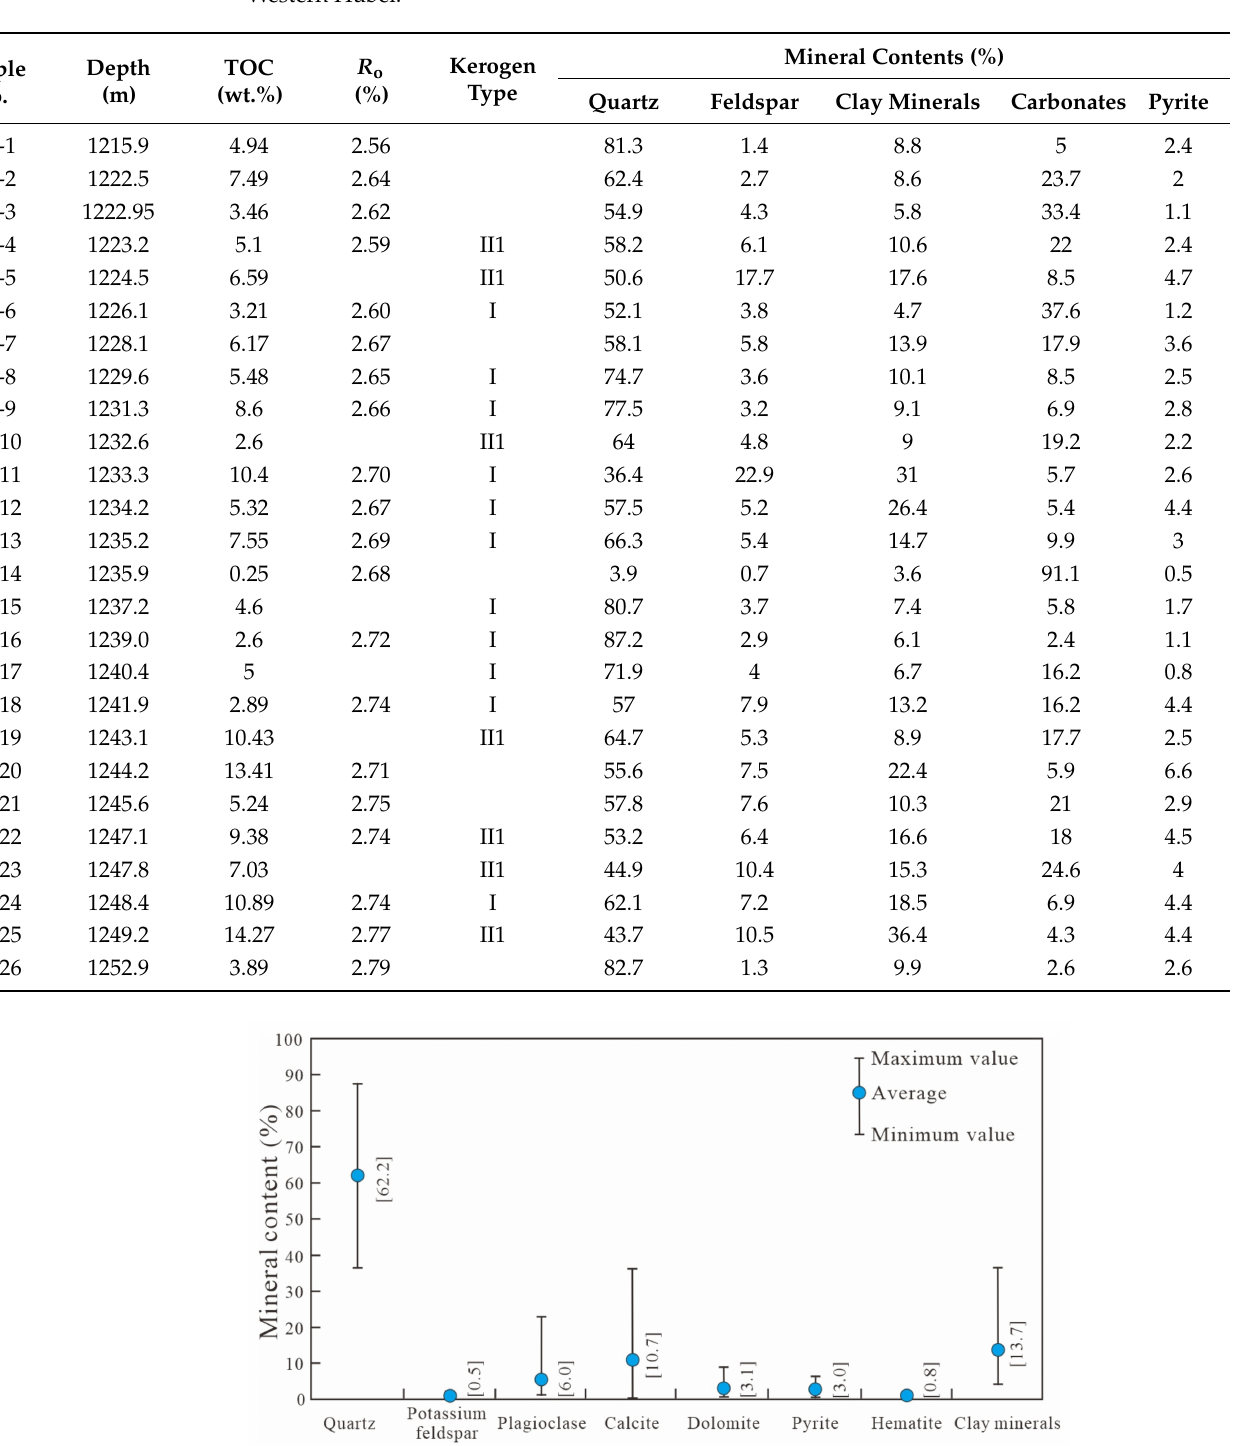
Figure 3. Mineral content of the Dalong Formation shales in well ED-2 in Western